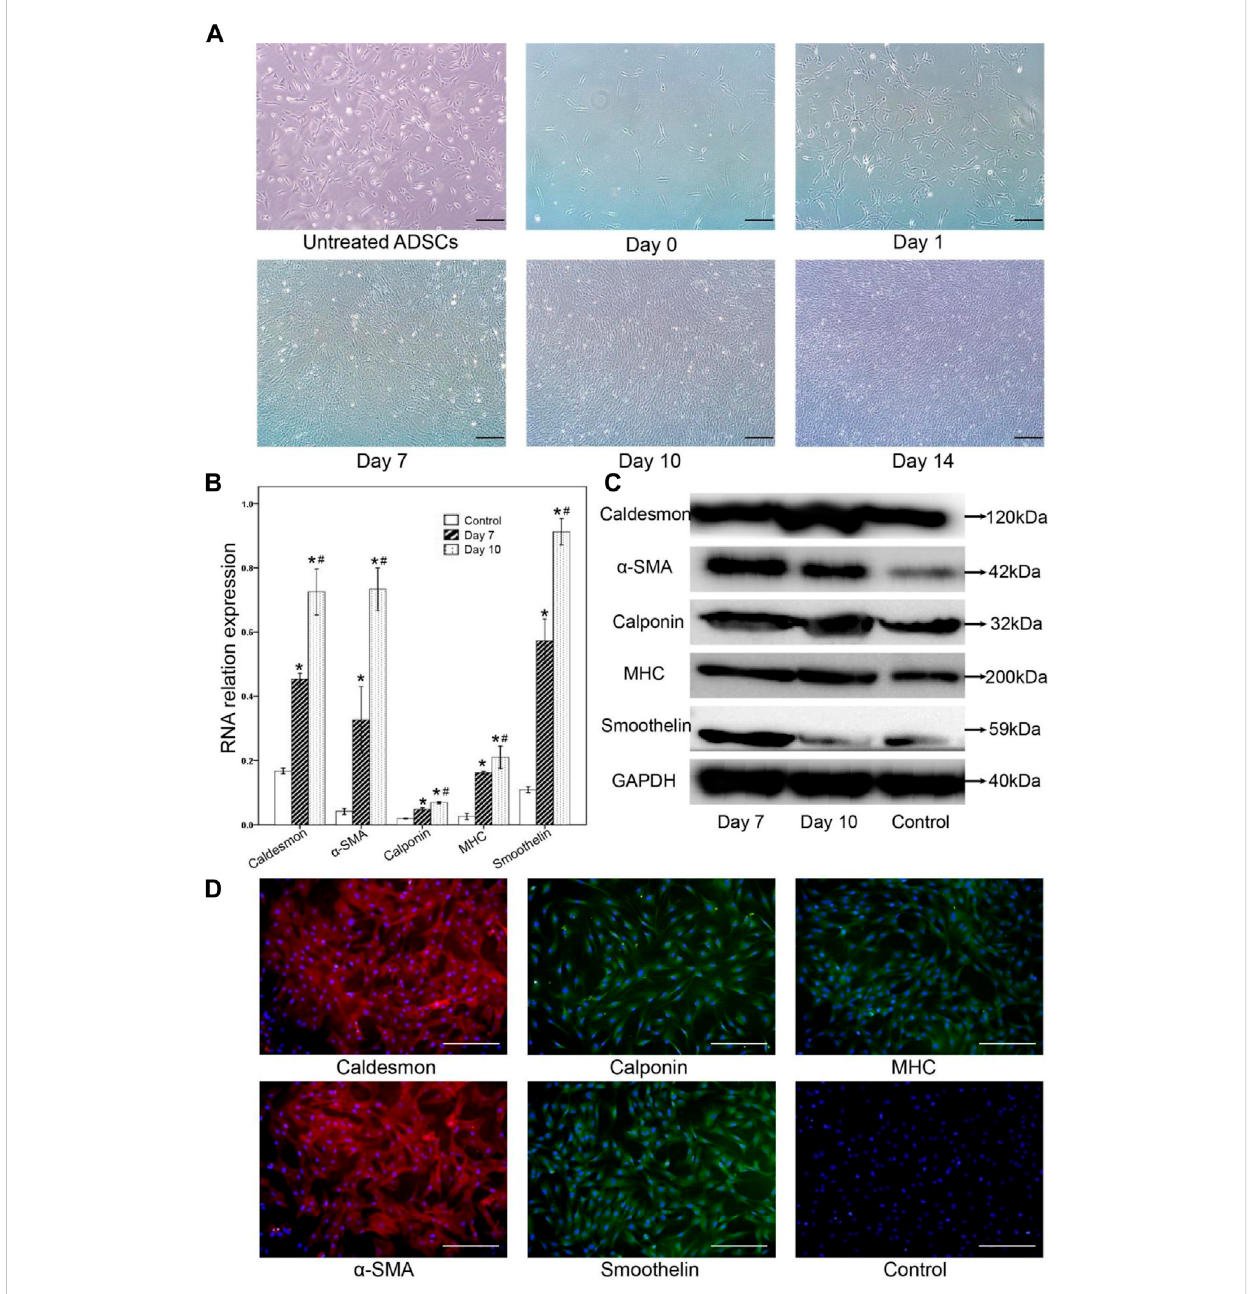
FIGURE 2 The morphological changes of adipocytes and the changes of smooth muscle-related markers after muscle differentiation were observed by RT- PCR, Western blot analysis, and immuno fl uorescence staining. (A) After muscle tissue differentiation, the cell morphology gradually changed. From day 10,thecellswereinducedtobespindle-shaped,strip-shaped,and fi broblast-like cells,whiletheuntreatedADSCsformedmonolayer fi broblast-likecells (control group). (B) Gene expression of caldesmon, α -SMA, calponin, MHC, and smoothelin was signi fi cantly detected in smooth muscle-like cells onday7,thenenhanced10 daysaftermuscledifferentiation.Undifferentiatedcellsweresetasanegativecontrol.*Comparedwiththeuninducedgroup, the difference was statistically signi fi cant; # Day 10 compared with the day 7 group, the difference was signi fi cant. (C) Western blot analysis of smooth muscular-related markers in the smooth muscle-like cells on day 7, and day 10, undifferentiated adipose-derived stromal cells (ADSCs) served as a negative control. (D) On day 10 after differentiation, immuno fl uorescence staining showed that differentiated smooth muscle-like cells expressed heavy calmodulin-binding protein, α -SMA, calmodulin, MHC, and smoothelin, while undifferentiated ADSCs did not express smooth muscle-related markers. Scale bar = 200 μ